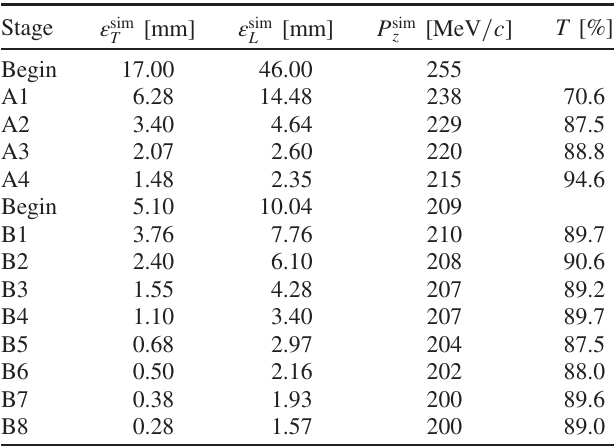
TABLE II. Simulation results of the normalized emittance and momentum at the exit of each stage of our proposed rectilinear channel. The last column shows the transmission, T , of each stage.